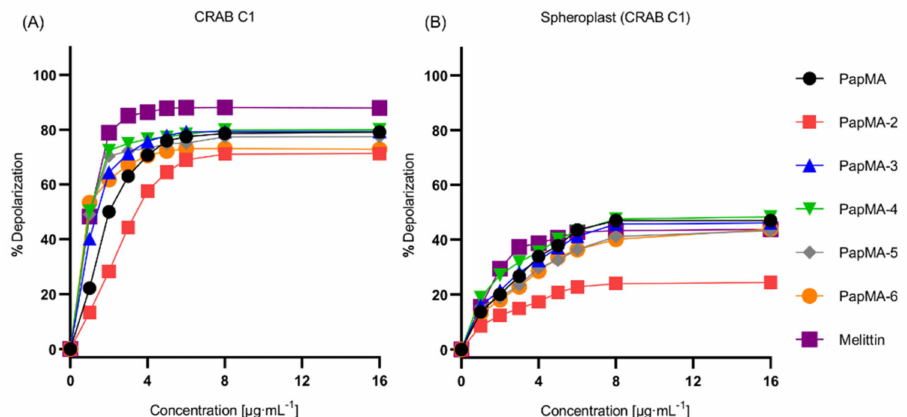
Figure 3. CRAB C1 membrane destruction caused by PapMA analogs. The concentration dependent depolarization of ( A ) intact CRAB C1 and its ( B ) spheroplast induced by PapMA and its analogs, determined using the membrane potential- sensitive fluorescent dye diSC 3 -5. Dye release was monitored by measuring fluorescence, at an excitation wavelength of 654 nm and an emission wavelength of 670